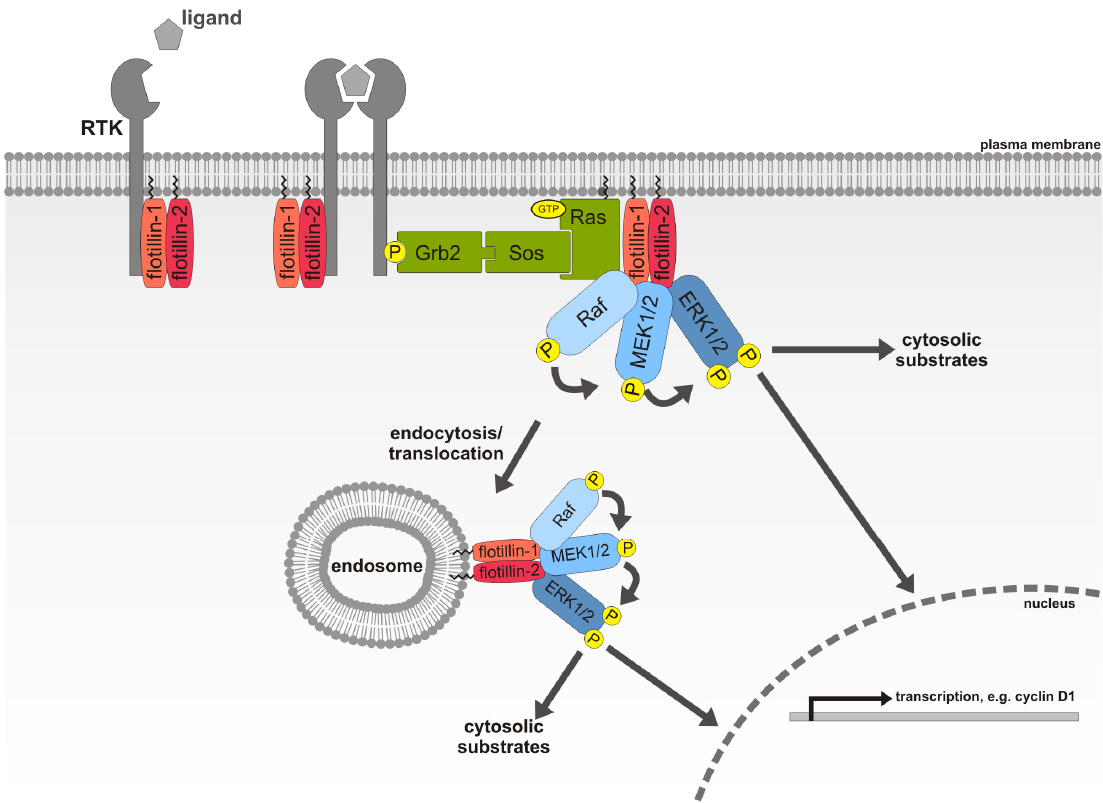
Figure 3. Flotillins are novel scaffolding proteins for the ERK/MAPK pathway. Both flotillins associate with the epidermal growth factor receptor (EGFR) and are necessary for a proper activation of the receptor and its downstream MAPK signaling